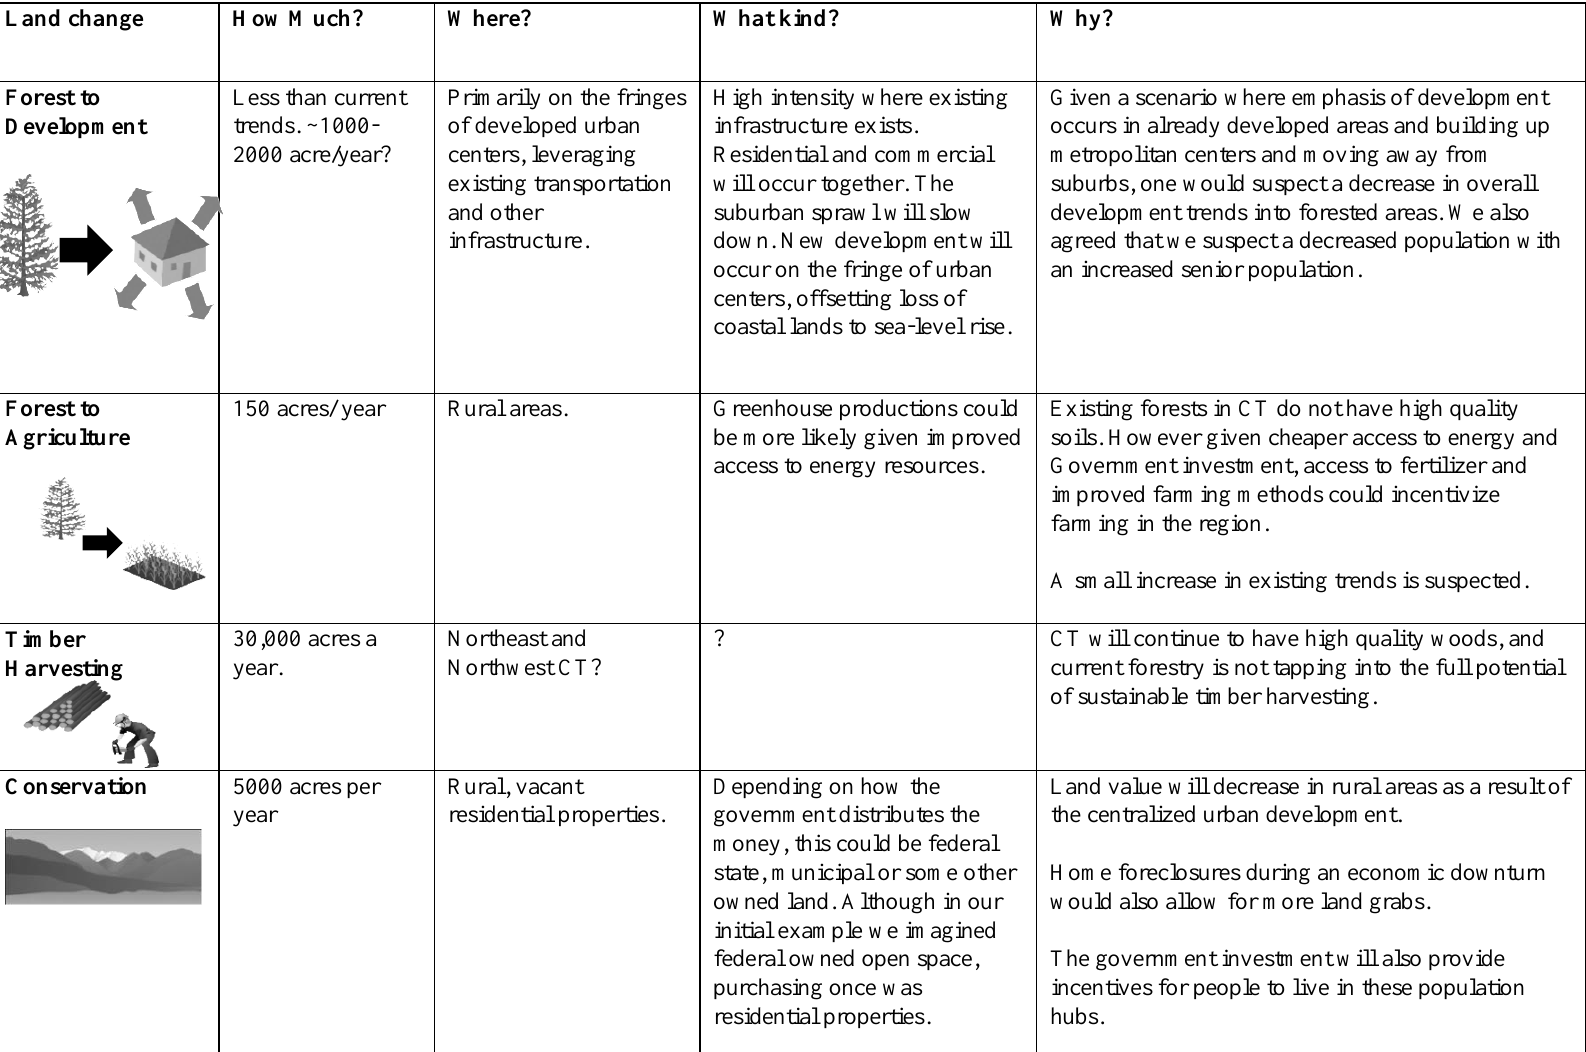
Table A2.16. Scenario 4: Mo’